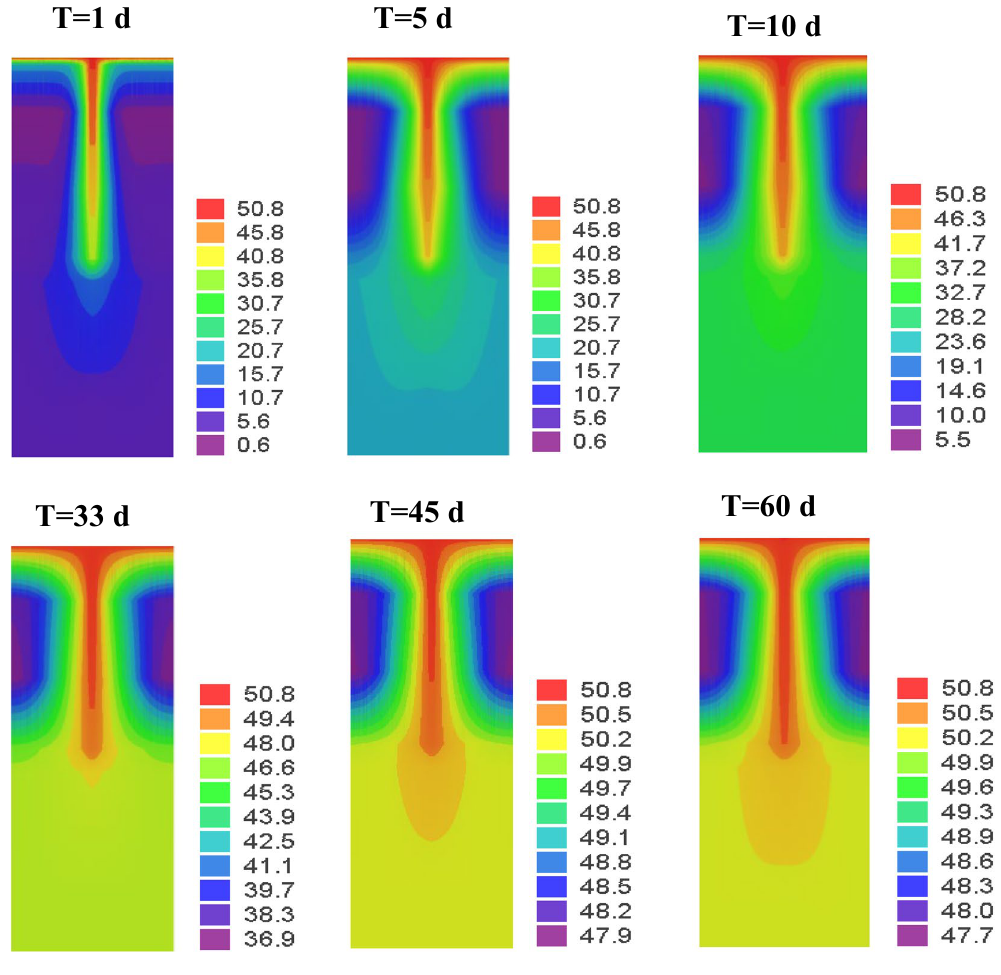
Figure 5. Cloud map of solute